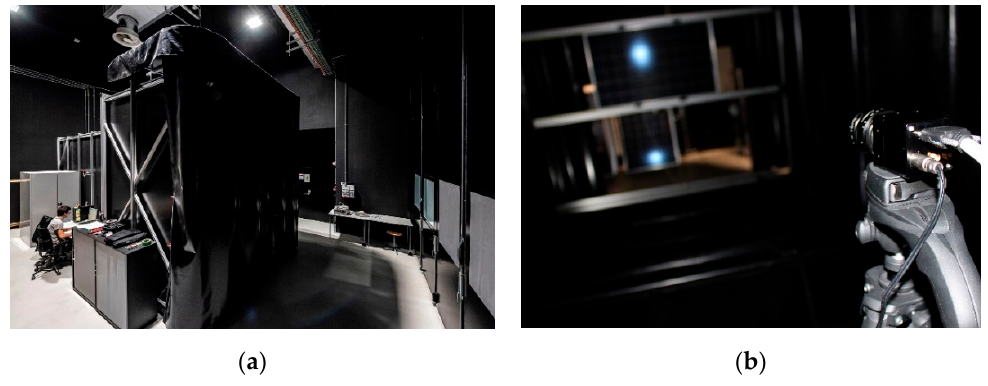
Figure 3. Indoor “Solare PV Lab”: ( a ) panoramic view of solar simulator room; and ( b ) electroluminescence test execution.